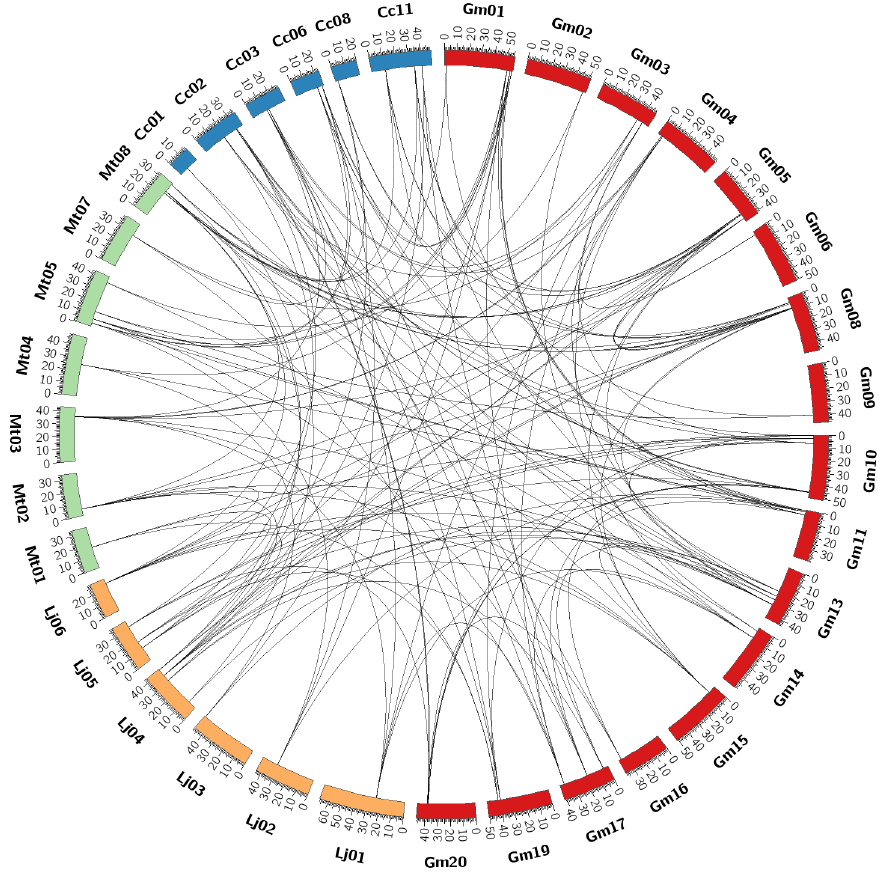
Figure 4. Extensive microsynteny of Hsf regions across L . japonicus , M . truncatula , G.max and C.cajan . G. max chromosomes, labeled Gm, are indicated by red boxes. The L . japonicus , M . truncatula and C. cajan chromosomes, shown in different colors, are labeled Lj, Mt and Cc, respectively. Numbers along each chromosome box indicate sequence lengths in megabases. The whole chromosomes of these four legumes, harboring Hsf regions, are shown in a circle. Black lines represent the syntenic relationships between Hsf regions.